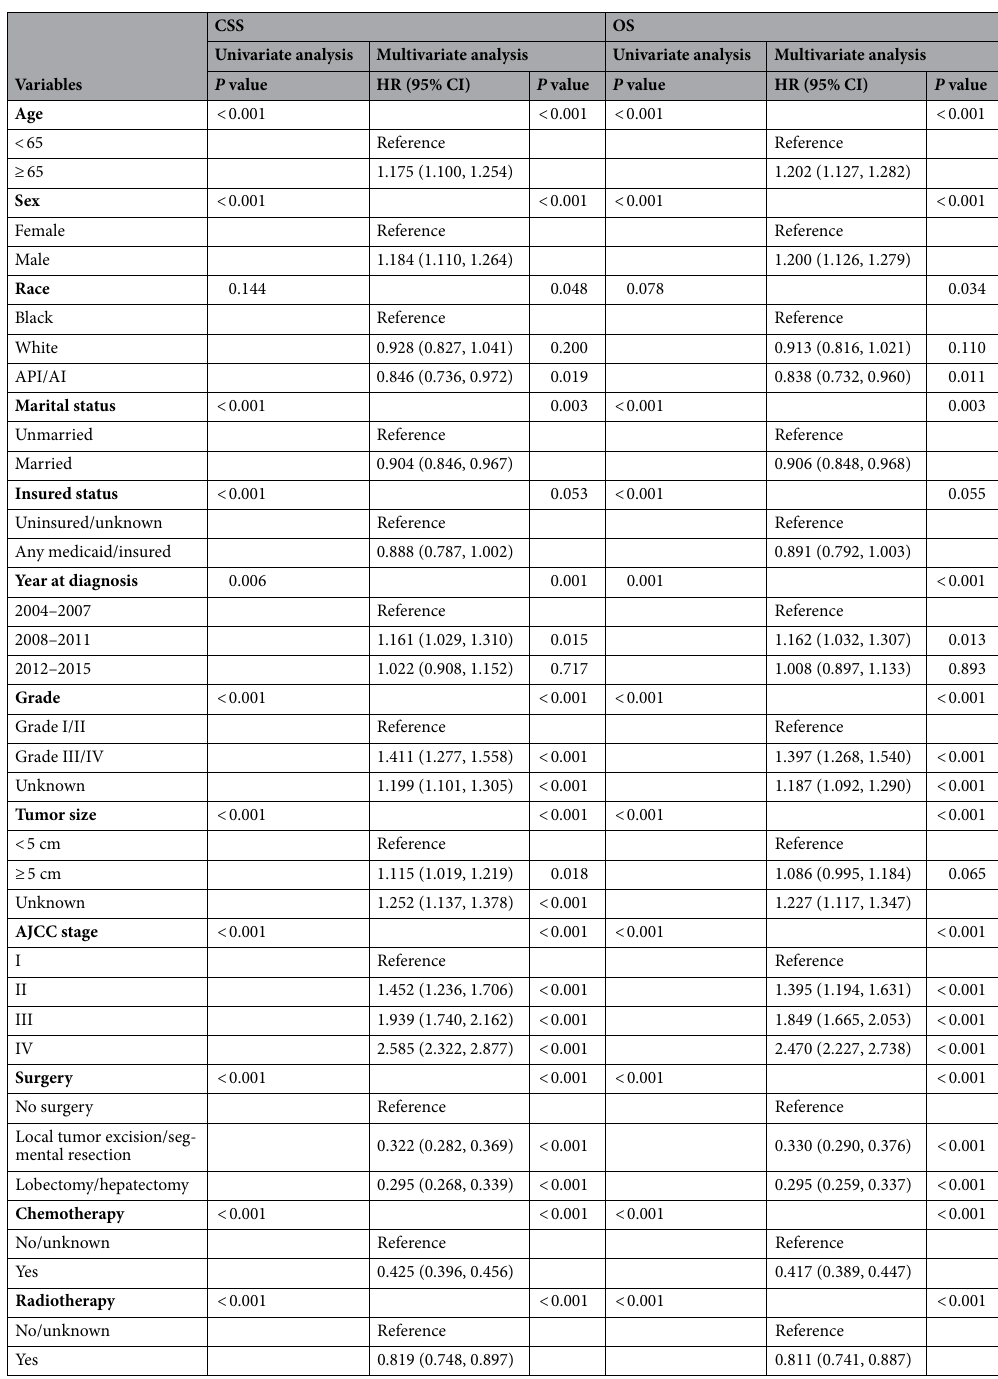
Table 2. Univariate and multivariate analyses of cancer special survival (CSS) and overall survival (OS) for 4595 patients with intrahepatic cholangiocarcinoma. API/AI American Indian/AK Native, Asian/Pacific Islander, CSS cancer ‐ specific survival, OS overall